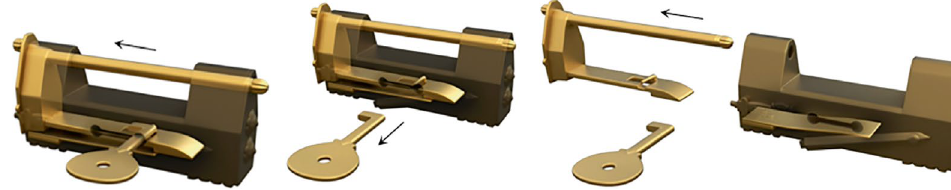
Figure 8. Simulation of sliding end-plate